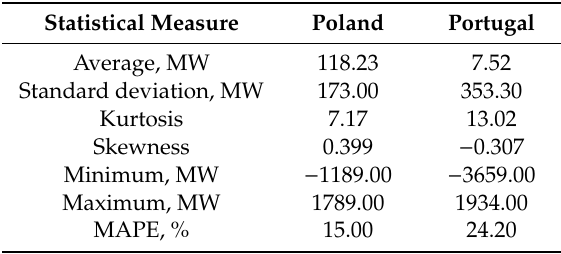
Table 3. Statistical description of the wind energy forecast error for Poland and Portugal in 2016.